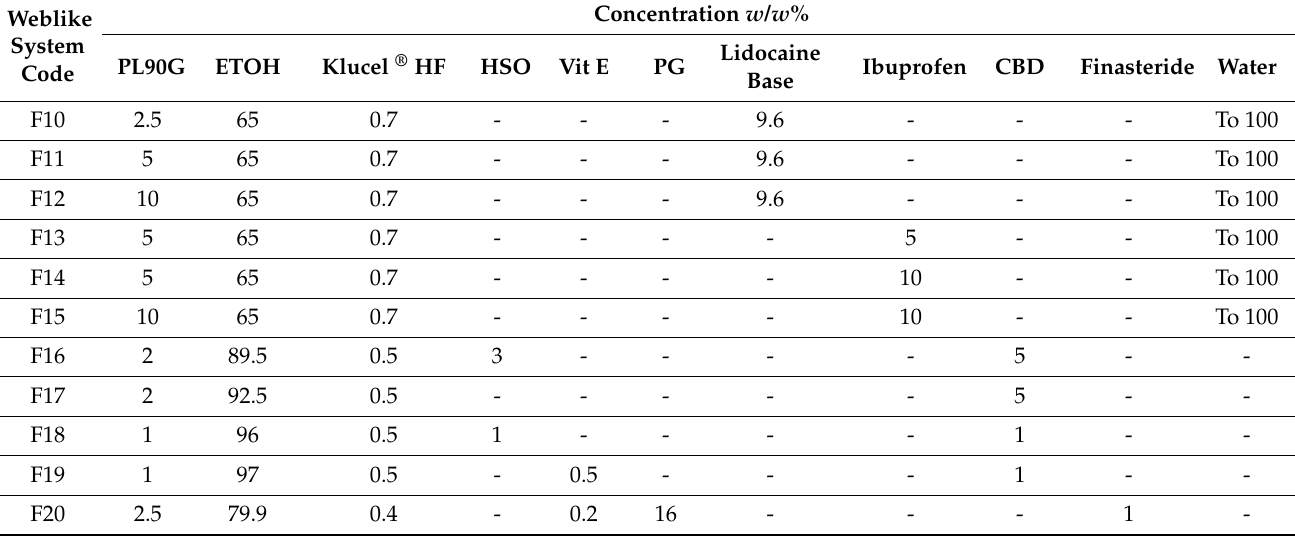
Table 2. Composition of Weblike systems containing